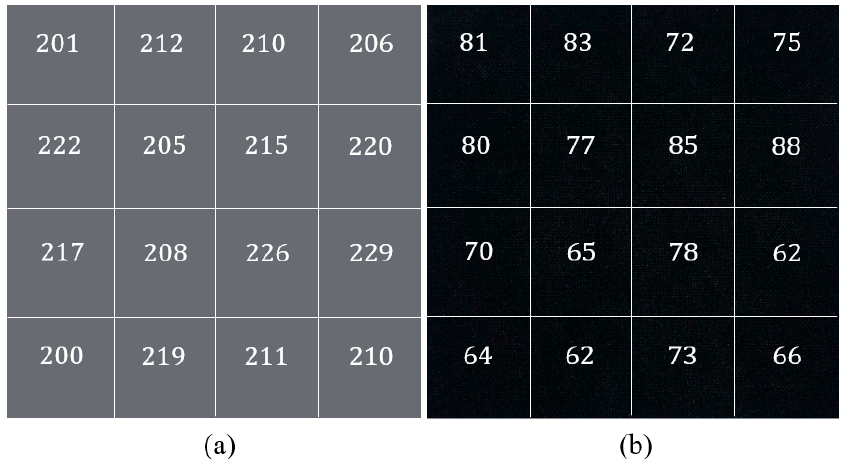
Figure 4. Representation of surface resistivity and the coating tone of the ( a ) nylon–Lycra, and ( b ) PET fabric samples after being coated with PPy by using the reactant concentrations 0.08 M AQSA, 0.05 M pyrrole and 0.05 M iron(III) chloride.